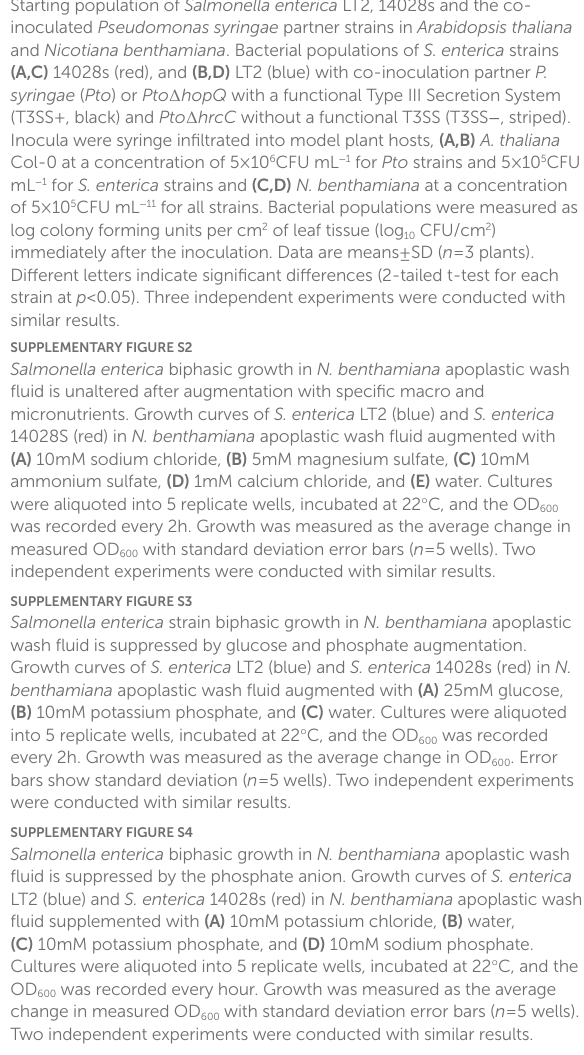
SUPPLEMENTARY FIGURE S1 Starting population of Salmonella enterica LT2, 14028s and the co- inoculated Pseudomonas syringae partner strains in Arabidopsis thaliana and Nicotiana benthamiana . Bacterial populations of S. enterica strains (A,C) 14028s (red), and (B,D) LT2 (blue) with co-inoculation partner P. syringae ( Pto ) or Pto ∆ hopQ with a functional Type III Secretion System (T3SS+, black) and Pto ∆ hrcC without a functional T3SS (T3SS − , striped). Inocula were syringe infiltrated into model plant hosts, (A,B) A. thaliana Col-0 at a concentration of 5 × 10 6 CFU mL − 1 for Pto strains and 5 × 10 5 CFU mL − 1 for S. enterica strains and (C,D) N. benthamiana at a concentration of 5 × 10 5 CFU mL − 11 for all strains. Bacterial populations were measured as log colony forming units per cm 2 of leaf tissue (log 10 CFU/cm 2 ) immediately after the inoculation. Data are means ± SD ( n = 3 plants). Different letters indicate significant differences (2-tailed t-test for each strain at p < 0.05). Three independent experiments were conducted with similar results. SUPPLEMENTARY FIGURE S2 Salmonella enterica biphasic growth in N. benthamiana apoplastic wash fluid is unaltered after augmentation with specific macro and micronutrients. Growth curves of S. enterica LT2 (blue) and S. enterica 14028S (red) in N. benthamiana apoplastic wash fluid augmented with (A) 10 mM sodium chloride, (B) 5 mM magnesium sulfate, (C) 10 mM ammonium sulfate, (D) 1 mM calcium chloride, and (E) water. Cultures were aliquoted into 5 replicate wells, incubated at 22 ° C, and the OD 600 was recorded every 2 h. Growth was measured as the average change in measured OD 600 with standard deviation error bars ( n = 5 wells). Two independent experiments were conducted with similar results. SUPPLEMENTARY FIGURE S3 Salmonella enterica strain biphasic growth in N. benthamiana apoplastic wash fluid is suppressed by glucose and phosphate augmentation. Growth curves of S. enterica LT2 (blue) and S. enterica 14028s (red) in N. benthamiana apoplastic wash fluid augmented with (A) 25 mM glucose, (B) 10 mM potassium phosphate, and (C) water. Cultures were aliquoted into 5 replicate wells, incubated at 22 ° C, and the OD 600 was recorded every 2 h. Growth was measured as the average change in OD 600 . Error bars show standard deviation ( n = 5 wells). Two independent experiments were conducted with similar results. SUPPLEMENTARY FIGURE S4 Salmonella enterica biphasic growth in N. benthamiana apoplastic wash fluid is suppressed by the phosphate anion. Growth curves of S. enterica LT2 (blue) and S. enterica 14028s (red) in N. benthamiana apoplastic wash fluid supplemented with (A) 10 mM potassium chloride, (B) water, (C) 10 mM potassium phosphate, and (D) 10 mM sodium phosphate. Cultures were aliquoted into 5 replicate wells, incubated at 22 ° C, and the OD 600 was recorded every hour. Growth was measured as the average change in measured OD 600 with standard deviation error bars ( n = 5 wells). Two independent experiments were conducted with similar